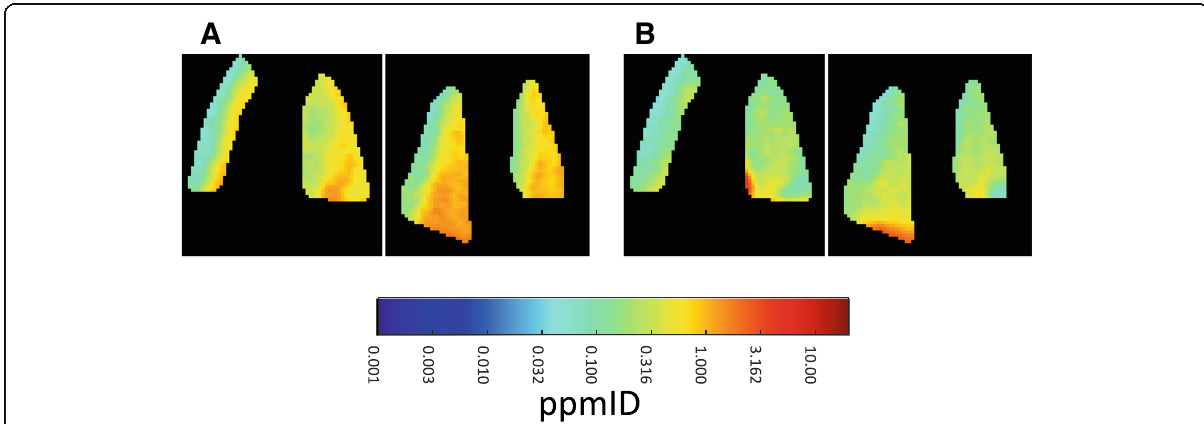
Fig. 3 Coronal slices of summation PET images (3 – 60 min) showing the distribution of radioactivity after intravenous injection of 11 C-VC-002 (in ppmID) in a non-human primate lung (NHP#1) at a baseline and b after intravenous administration of ipratropium (30 μ g/kg). The highest intravenous dose was represented to provide a visual impression of the dosing effect. The color scale is logarithmic